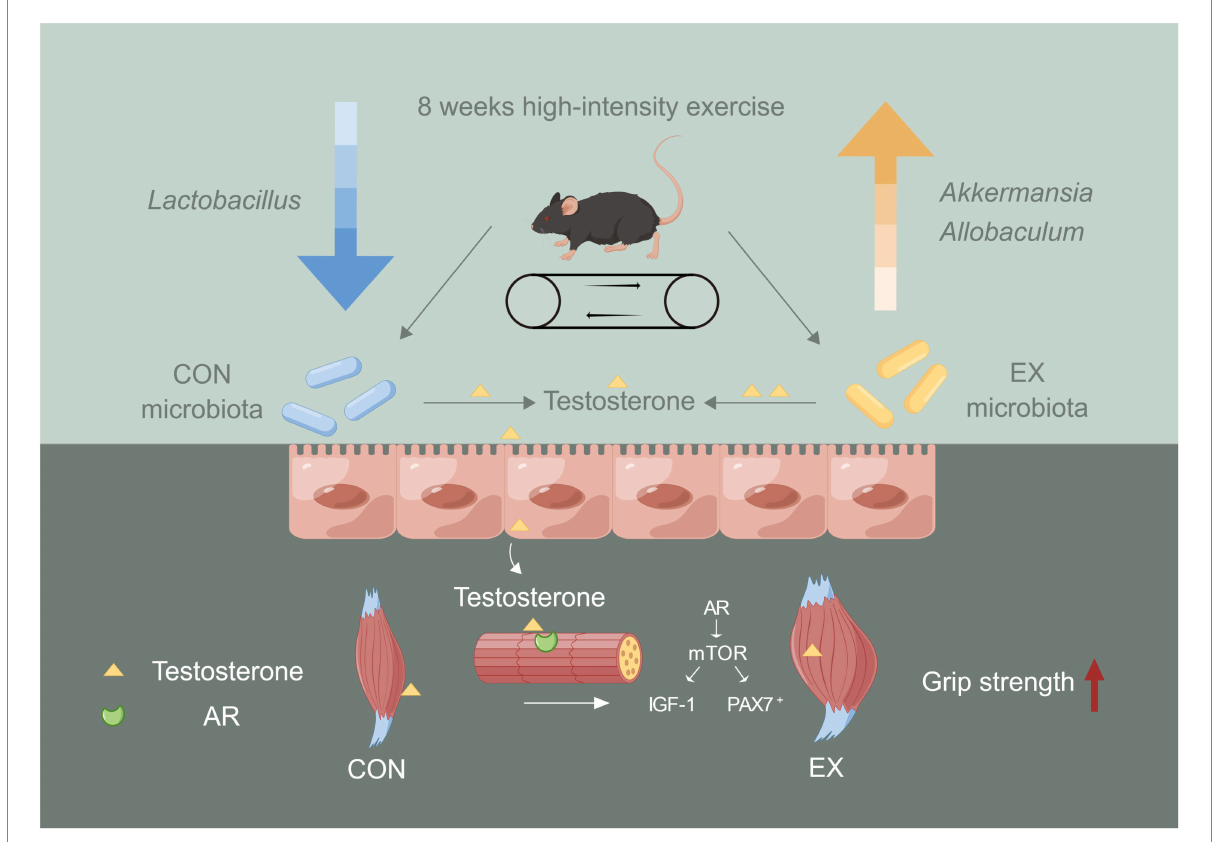
FIGURE 6 The role of gut microbiota on skeletal muscle performance by high-intensity aerobic exercise (by Figdraw). The long-term (8 weeks) high loading intensity of aerobic exercise improves serum testosterone levels and skeletal muscle performance by remodeling the gut microbiota’s structure (Lactobacillus, Allobaculum, and